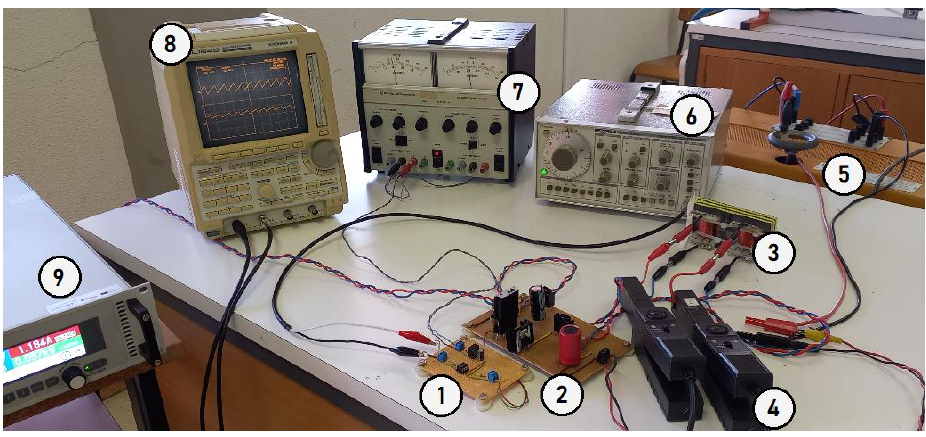
Figure 15. Experimental setup.